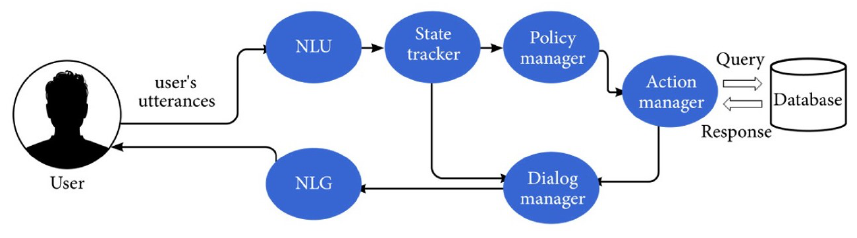
Figure 7. The main components of a goal-oriented